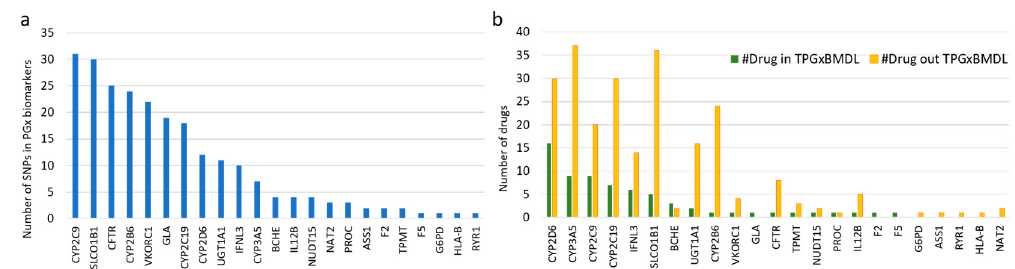
Figure 4. Numbers of SNPs and drugs related to biomarkers in TPGxBMDL. ( a ) The number of SNPs reported by public databases that are contained by biomarkers associated with drugs. ( b ) The number of drugs associated with SNPs in the biomarkers. Green bars represent the number of drugs listed in TPGxBMDL.